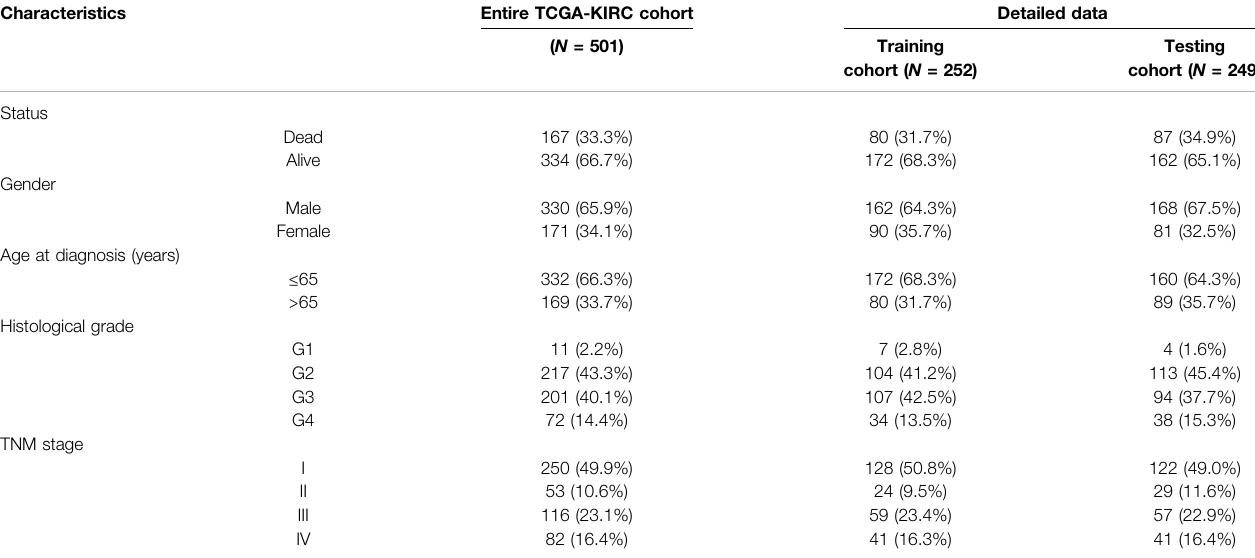
TABLE 1 | Clinical characteristics of 501 KIRC patients involved in the 5-gene prognostic signature construction and validation.